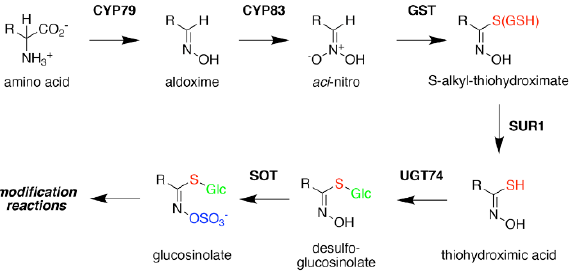
Figure 3. Glucosinolate Core Biosynthesis. A variety of amino acids (i.e., variable R-group), including elongated aliphatic methionine-derived molecules (see Figure 2), can be converted to aldoximes by members of the CYP79 cytochrome P450 family to begin construction of the core glucosinolate scaffold (see Figure 1, left). Members of the CYP83 family generate the unstable aci–nitro compounds believed to be the substrate of glutathione-S-transferases that introduce the shared sulfur atom. The SUR1 cysteine-sulfur lyase converts the S-alkyl-thiohydroximate to thiohydroximic acid, which is then modified with a glucosyl-residue by UDP-glucosyltransferase (UGT) family 74 enzymes. The final step of the pathway involves sulfation by PAPS-dependent sulfotransferases (SOT). Subsequent modification reactions of the core structure yield the molecular diversity of glucosinolates.